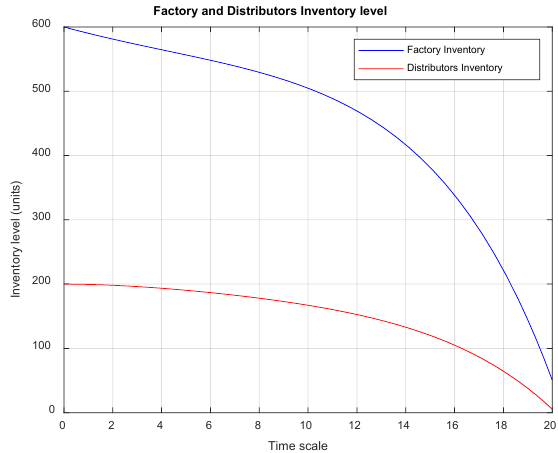
Figure 4. Factory and distributor inventory levels.